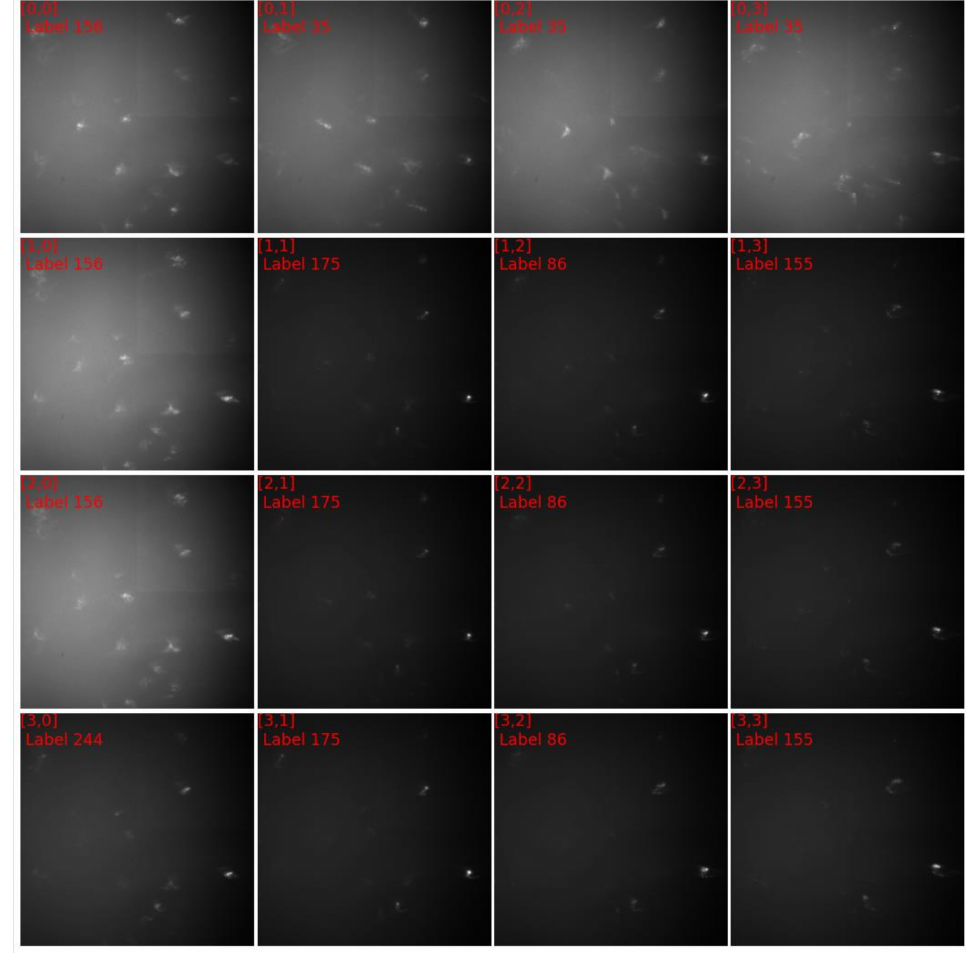
Figure 8. The diffraction images of subgrid A in Figure